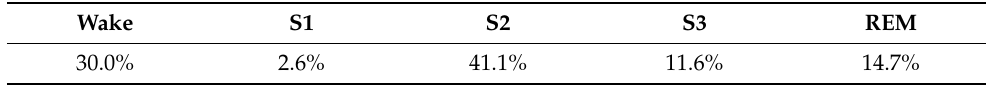
Table 2. Average percentage of sleep duration in each stage for the study